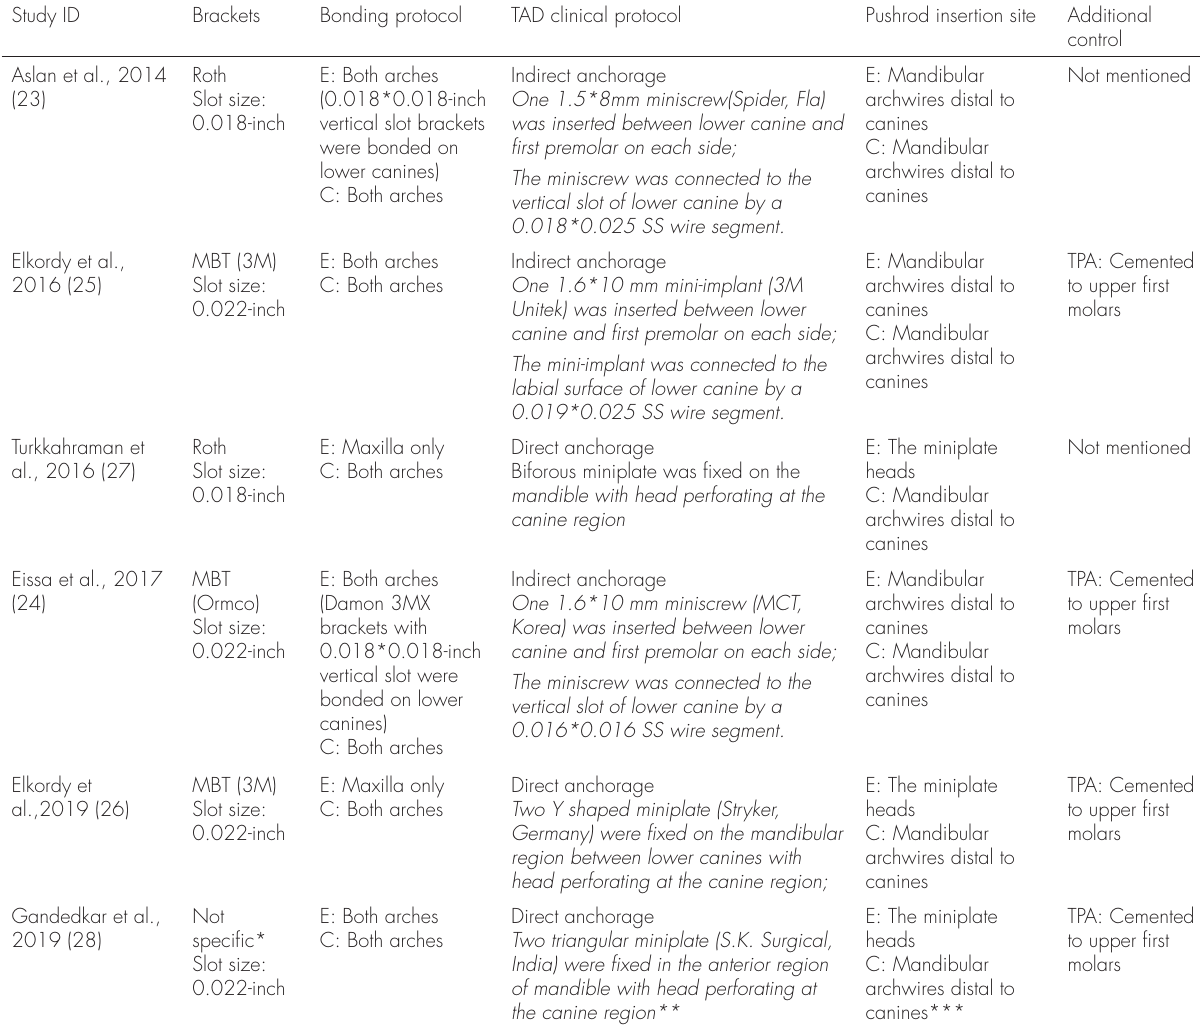
Table III. Intervention details of included studies.